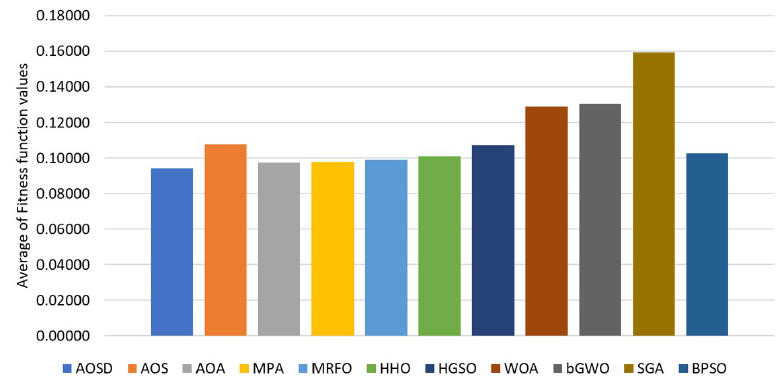
Figure 2. Average of the fitness functions’ values.